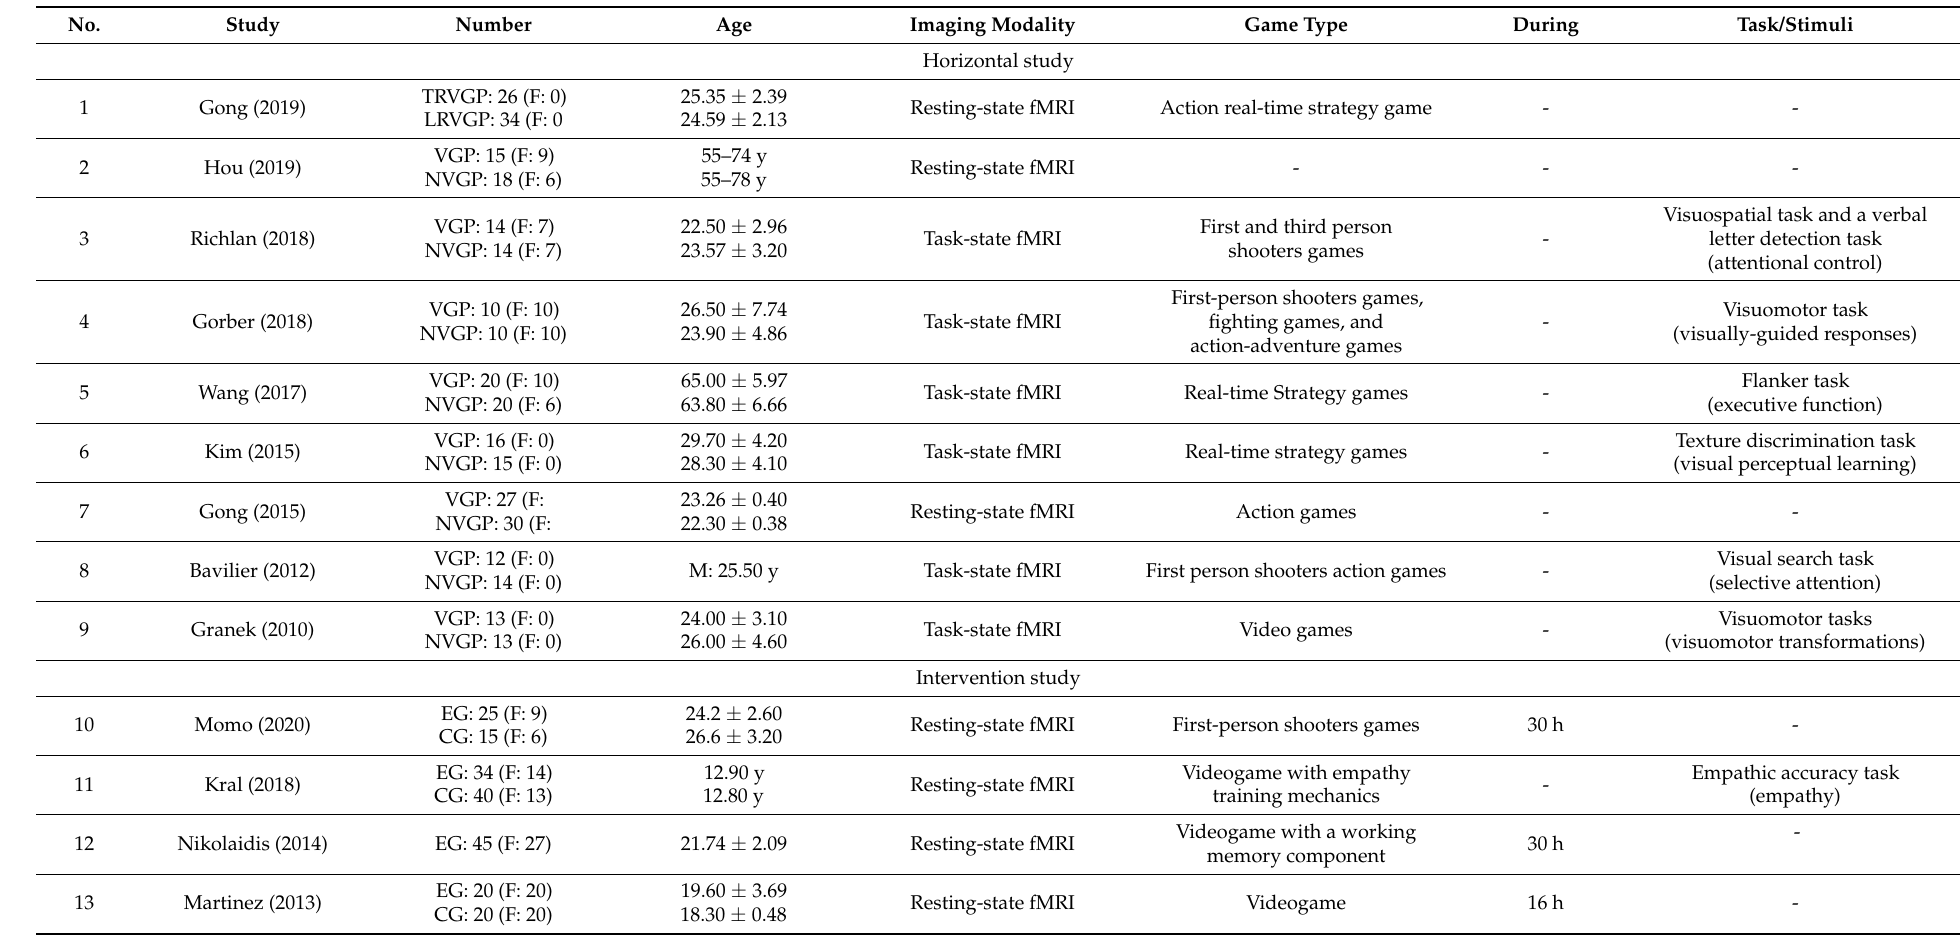
Table 1. Summary of participants’